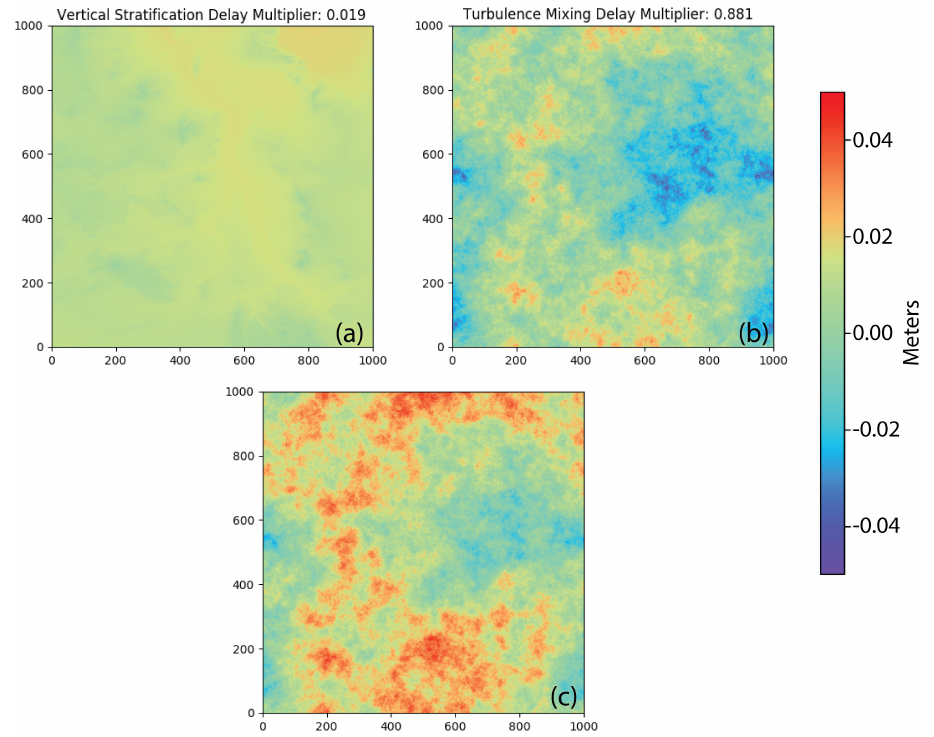
Figure 4. Simulated maps of tropospheric delay: ( a ) vertical stratification delay calculated with random multiplier 0.019, ( b ) turbulence mixing delay calculated with random multiplier 0.881, and ( c ) the resulting delay from the combination of vertical stratification ( a ) and turbulence mixing ( b )